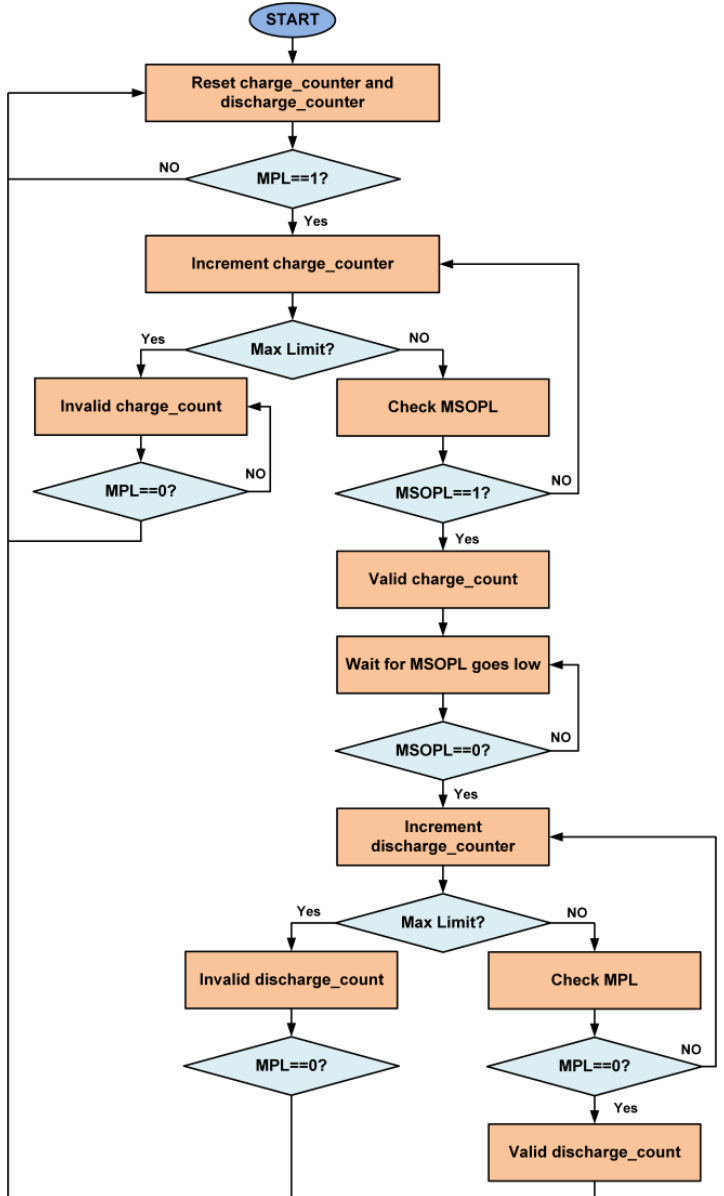
Figure 16. Flow diagram for the estimation of the charging and discharging rate of the supercapacitor at the SWIPT transmitter and receiver.